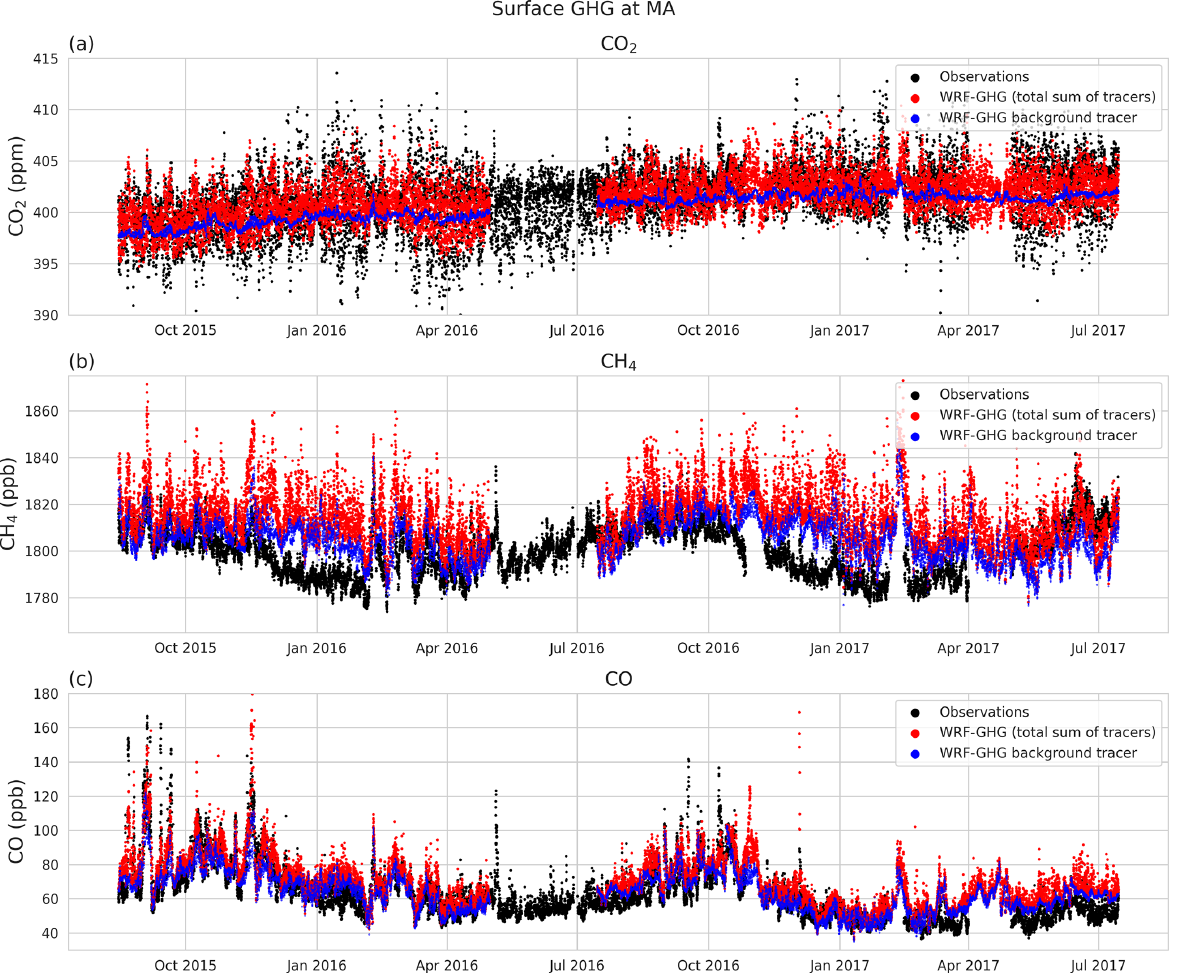
Figure C2. Time series of all observed (black) and modeled (red) in situ concentrations at MA of (a) CO 2 , (b) CH 4 , and (c) CO. The blue dots represent the modeled background